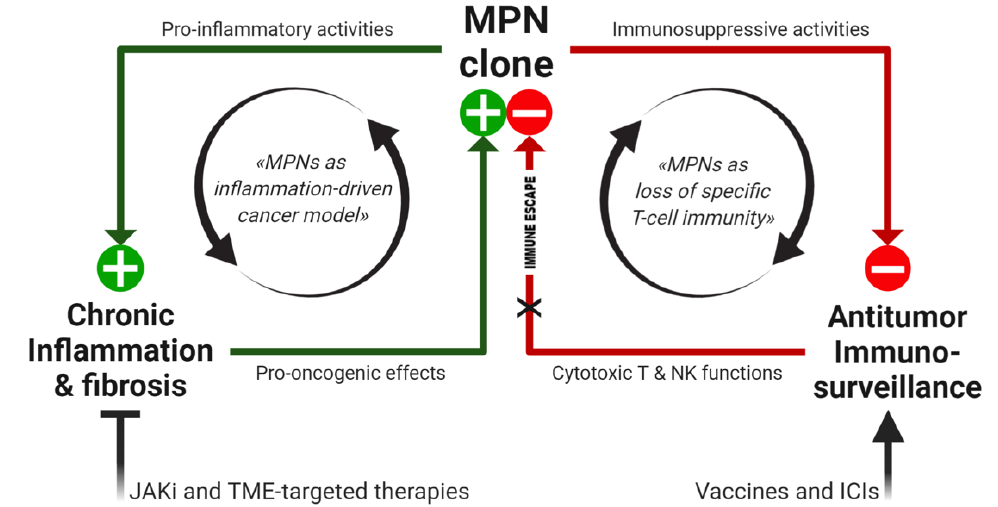
Figure 2. Working model of MPN immunopathogenesis and related immunotherapeutic strategies. In the MPN-associated BM niche, relevant immunological dynamics are sustained by the mutant clone, creating positive feedback loops (black arrows), which can directly promote tumor progression (through chronic inflammation, inducing genomic instability and ROS-dependent mutagenesis) as well as support the permissive microenvironment (by loss of MPN-specific protective immunity). Both immunopathogenetic features can be targeted by novel therapeutic approaches, aiming to inhibit JAK2 constitutive signaling, modulate the TME and restore antitumor immunosurveillance. JAKi: JAK inhibitors, TME: tumor